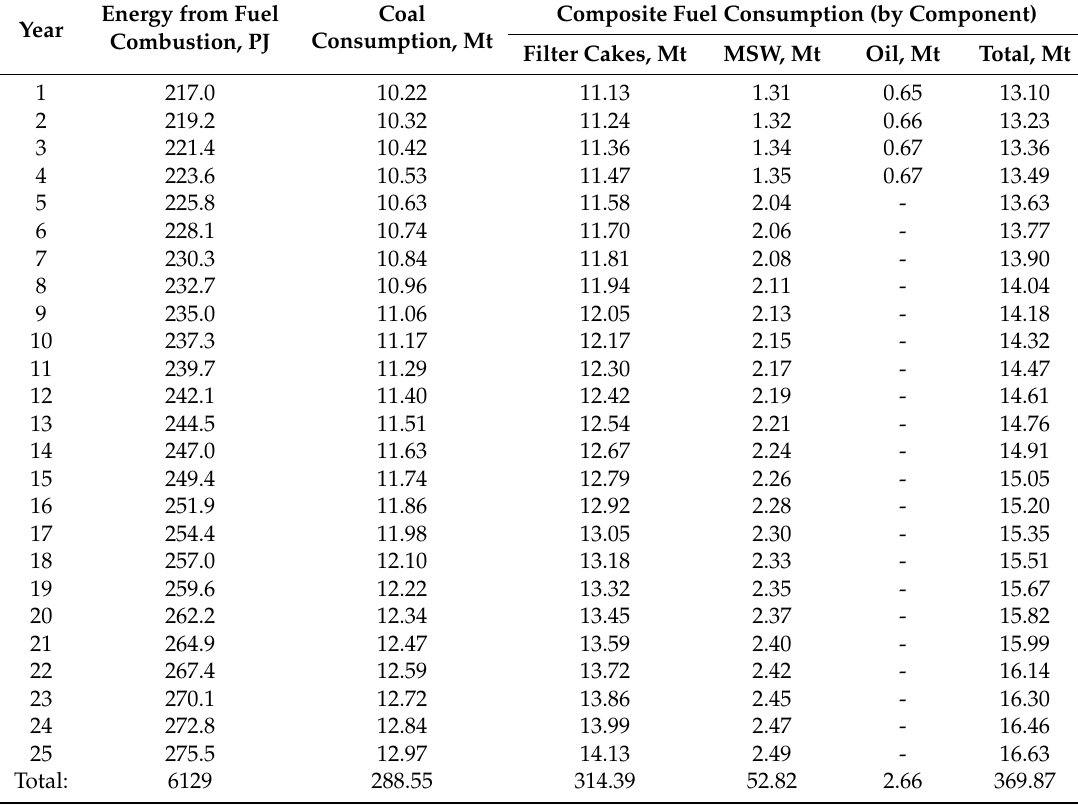
Table 10. Component consumption for composite fuel